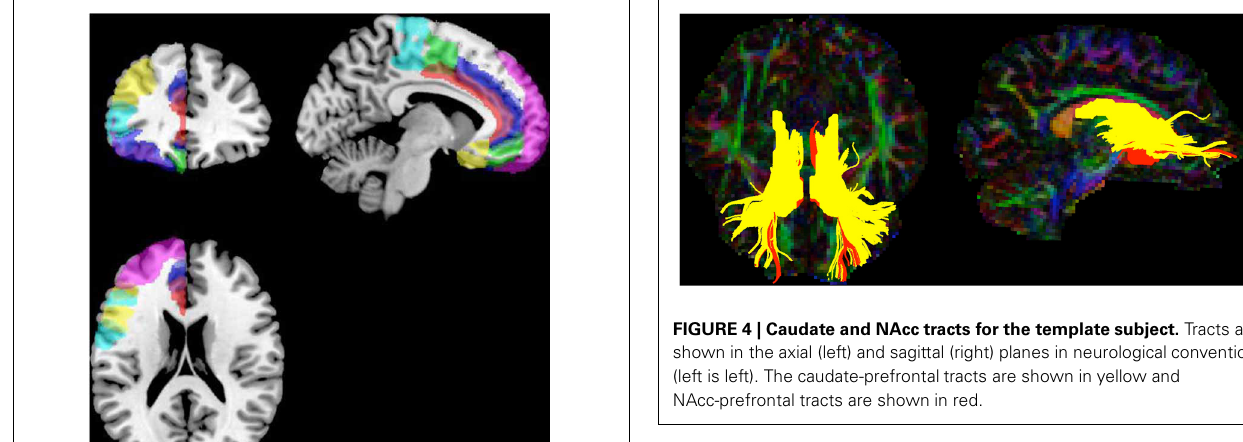
operators used to exclude tracts passing through other